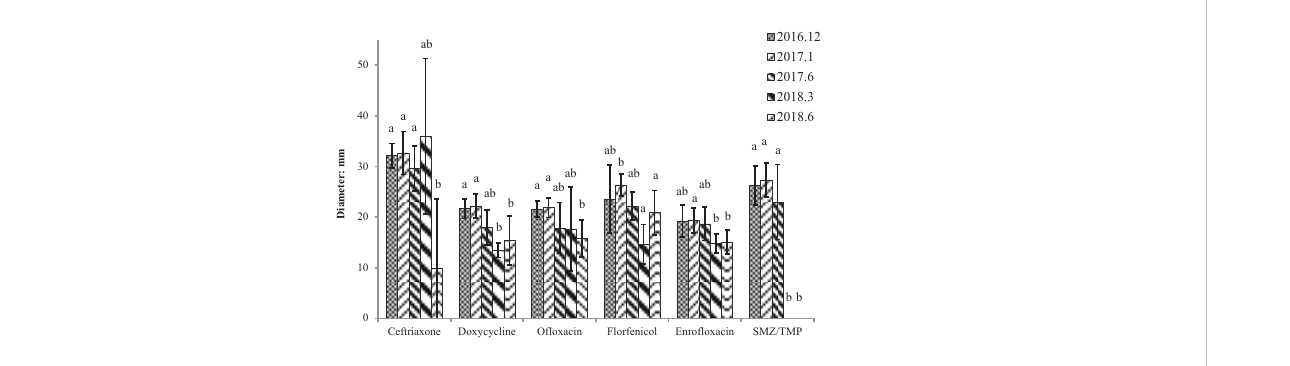
FIGURE 7 Antibiotic resistance of Edwardsiella piscicida strains isolated in Weifang city from October 2016 to June 2018. a, b: Differences letters indicate signi fi cant differences between different groups (P <